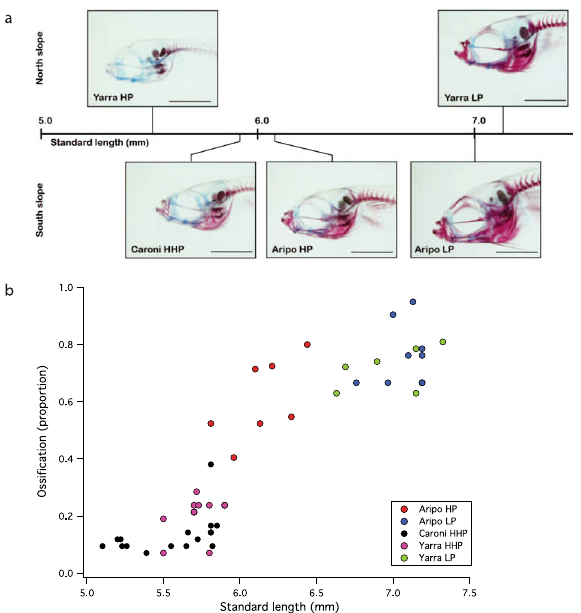
Figure 7. ( a ) Guppy neonates exhibit substantial variation in ossification of the head skeleton at birth. Cleared and stained neonatal specimens indicate cartilage (blue stain) and bone (red), from each of the five populations studied, aligned by standard length. North and South slope of the Northern Range Mountains in Trinidad indicated. Scale bar = 1 mm. All images to scale. ( b ) Development of the skull (as assessed by cranial ossification) increases rapidly with size among neonates. Of 18 skeletal elements examined within the head, the smallest neonates are born with fewer than 20% of these elements ossified. Neonates from LP environments are born ~20% larger, but with 400% greater ossification within the head skeleton. Populations are coded by